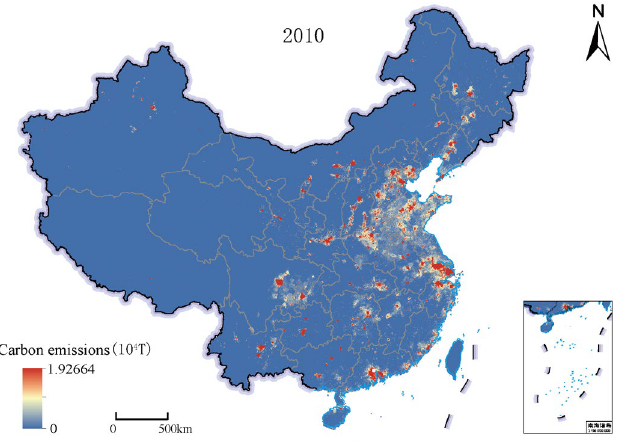
Figure 2. Results of 500 m spatialization of carbon emissions in China in 2010 based on the SVR-ZSSR model. This map is based on the standard map No. GS(2019) 1823 downloaded from the Ministry of Natural Resources Standard Map Service website. The base map is